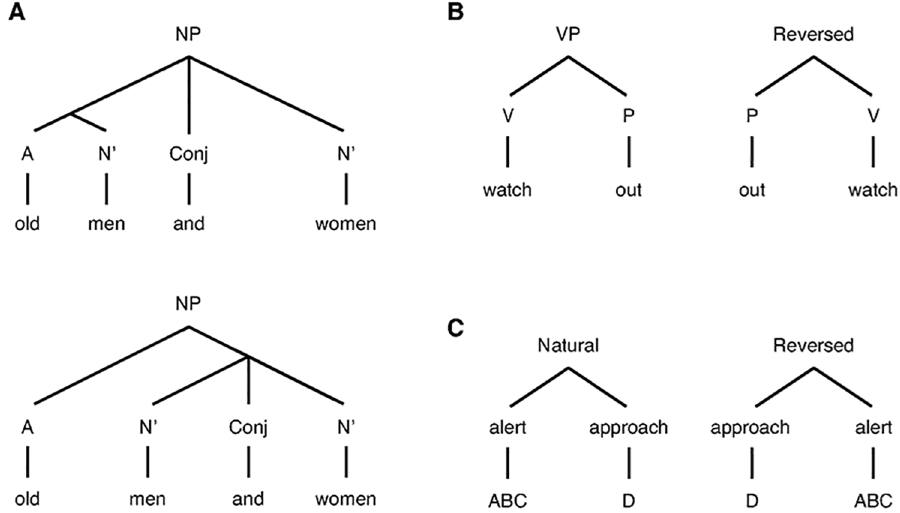
Fig 2. Examples of parse trees for human phrases and Japanese tit call sequences. ( A ) Ambiguity of meaning can be observed when more than two words are strung together ([[old men] and [women]] or [old [men and women]], see [11]). ( B ) The meaning of phrase depends on syntactic structure. ( C ) The meaning of Japanese tit sequence also depends on how meaningful calls are combined, indicating that there is also a syntactic structure in which call ordering governs the meaning of sequence. A, adjective; Conj, conjunctive; N’, noun; NP, noun phrase; P, preposition; V, verb; VP, verb phrase.